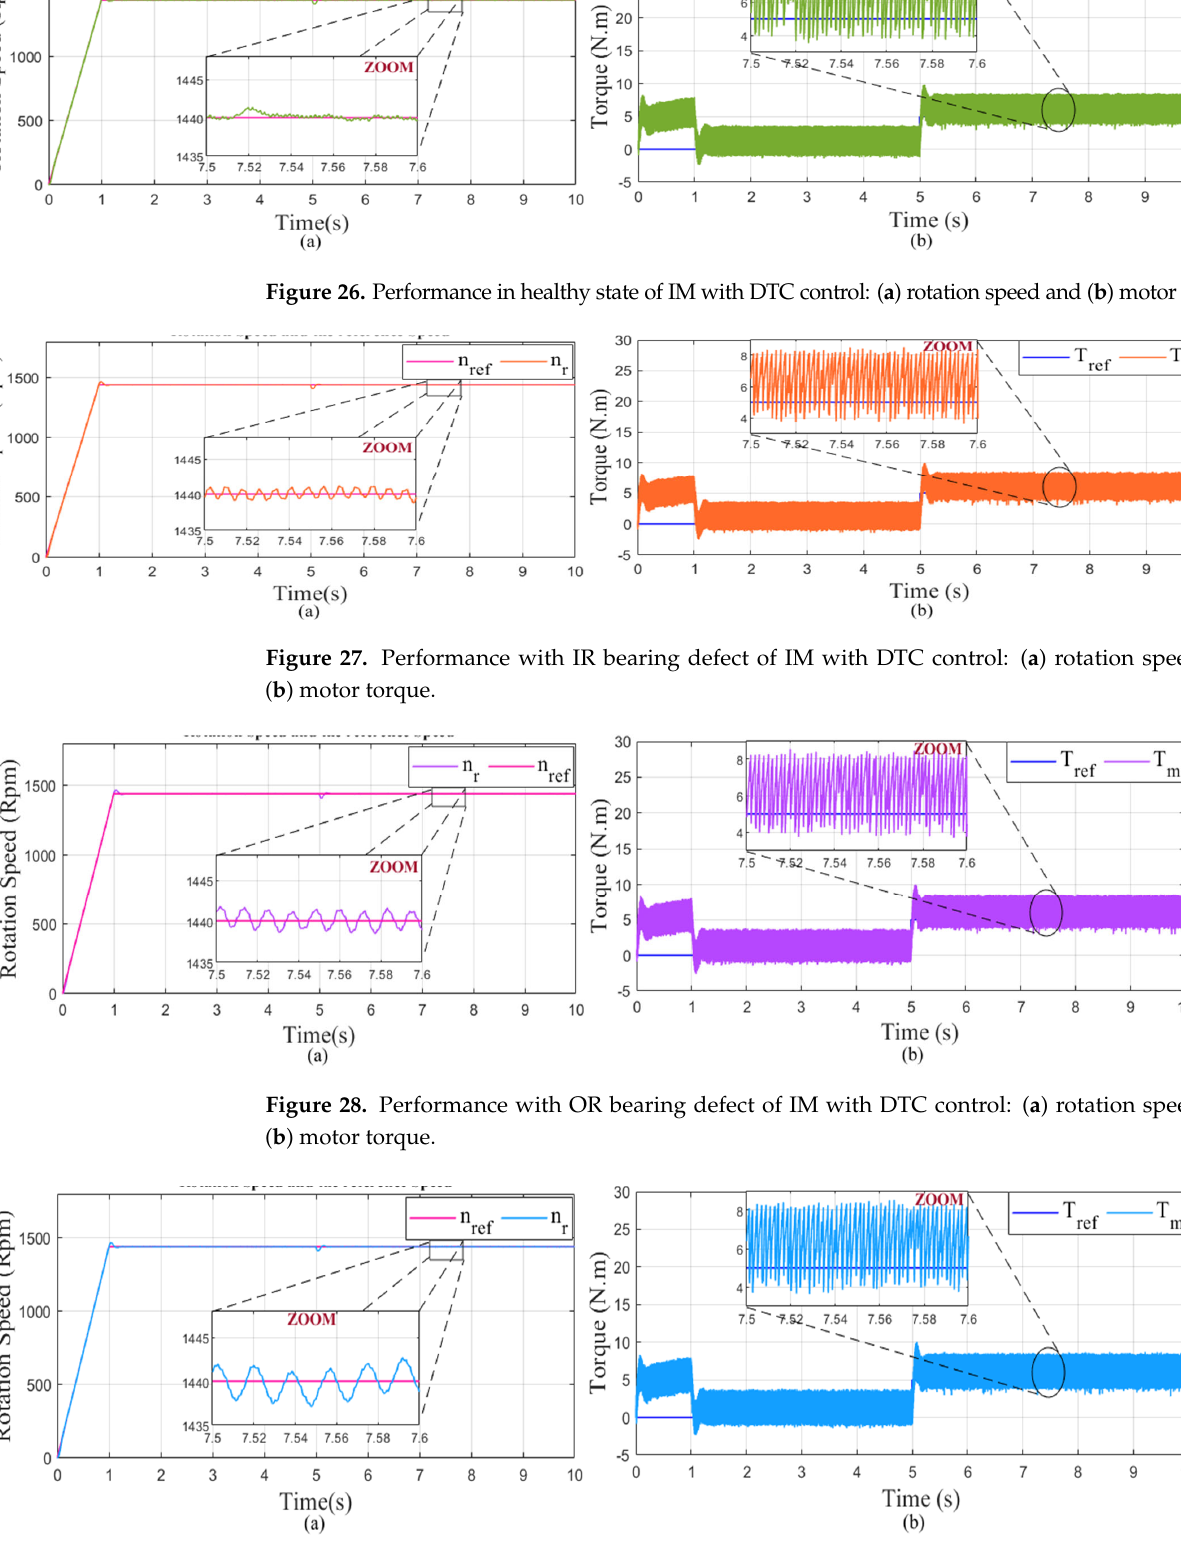
Figure 30. Performance with Cage bearing defect of IM with DTC control: ( a ) rotation speed and ( b ) motor torque.